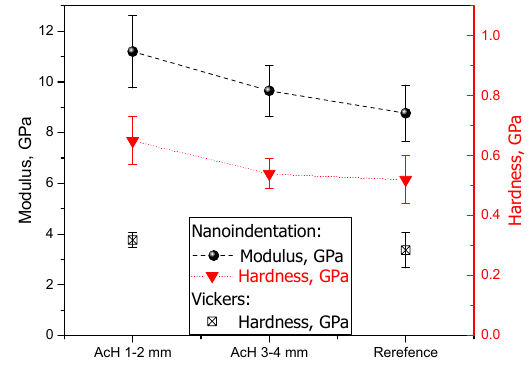
Figure 12. Young’s modulus and Hardness results from indentation tests showing the effect of acid attack with degradation depths (1 ‐ 2 mm and 3 ‐ 4